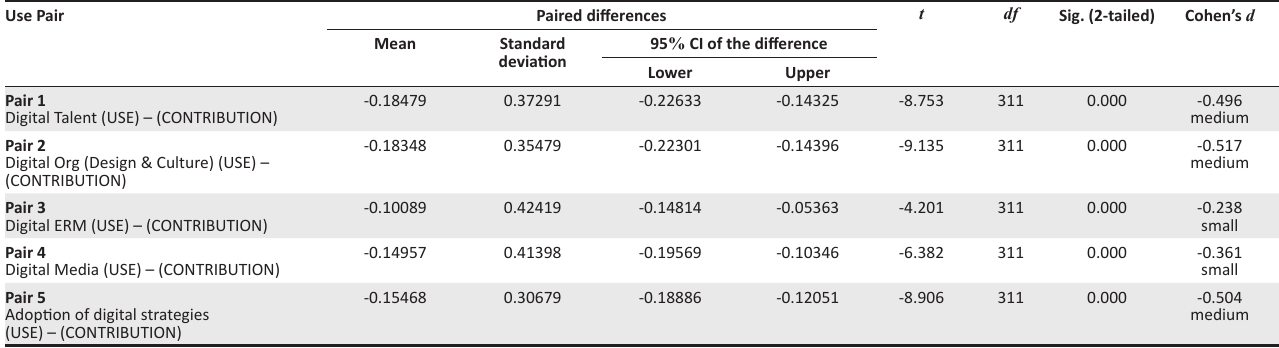
TABLE 3: Paired sample t -tests and Cohen’s d for the factors. Use Pair